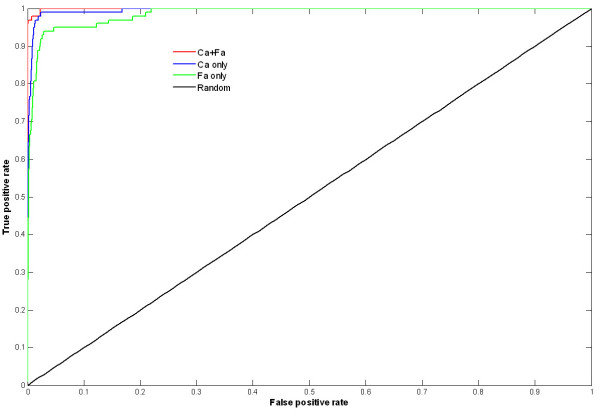
ROC curves of Ca only, Fa only and combining both Ca and Fa. The ROC curves were generated by 1mct active site (H57, D102 and S195) querying to nrSCOP using CMASA. The CMASA hits were ranked by P-value. The totally positives was 100 (85 trypsins and 15 subtilisins), and the totally negatives was 14441 (14541 nrSCOP minus 100 positives).